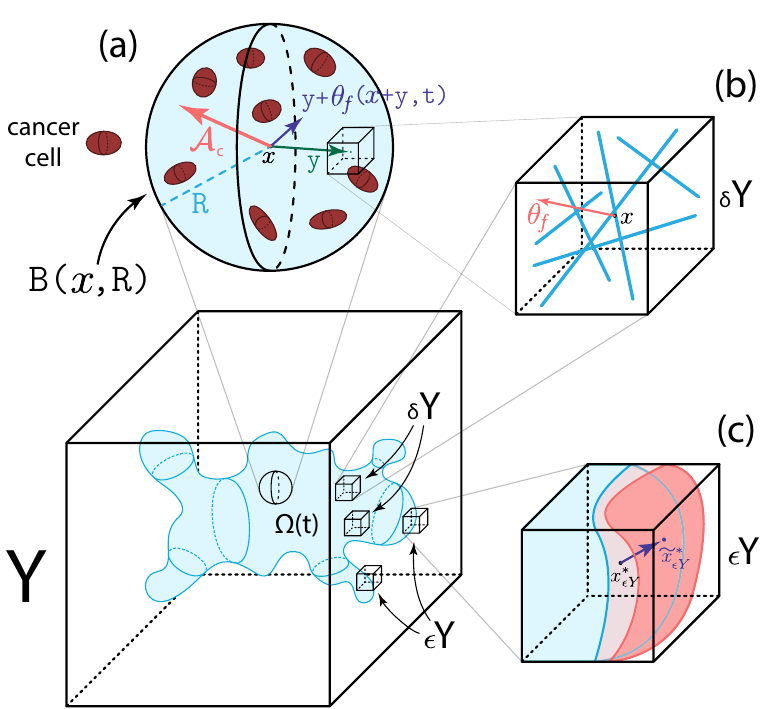
Figure 1. Schematics of the multi-scale model: ( a ) Illustration of the sensing region B ( x , R ) , the two vectors y and y + θ f ( y + x , t ) and the overall travelling direction A c ; ( b ) an example of a fibre micro-domain δ Y ( x ) containing fibres (blue lines) that induces an overall orientation θ f ( x , t ) for δ Y ( x ) ; ( c ) an example of a boundary micro-domain (cid:101) Y ( x ) where the blue volume represents the tumour volume at the current time-step with boundary point x and the red volume represents the evolved tumour at the next time-step with shifted boundary point x ∗ (cid:101) Y